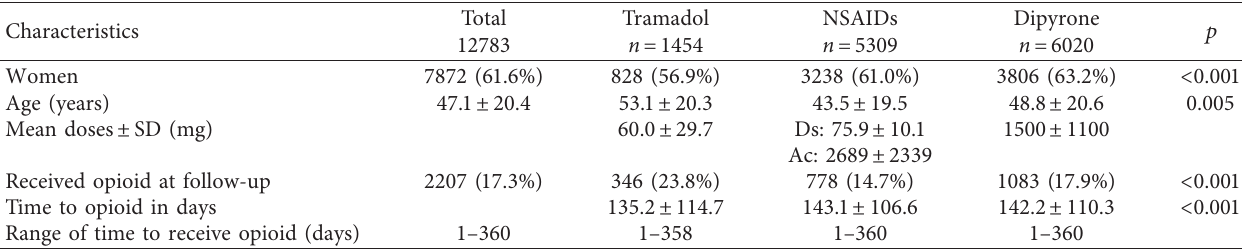
Table 1: Clinical characteristics related to the prescription of tramadol, nonsteroidal anti-inflammatory drugs, and dipyrone in 12,783 patients treated in the emergency departments of five clinics in Colombia,